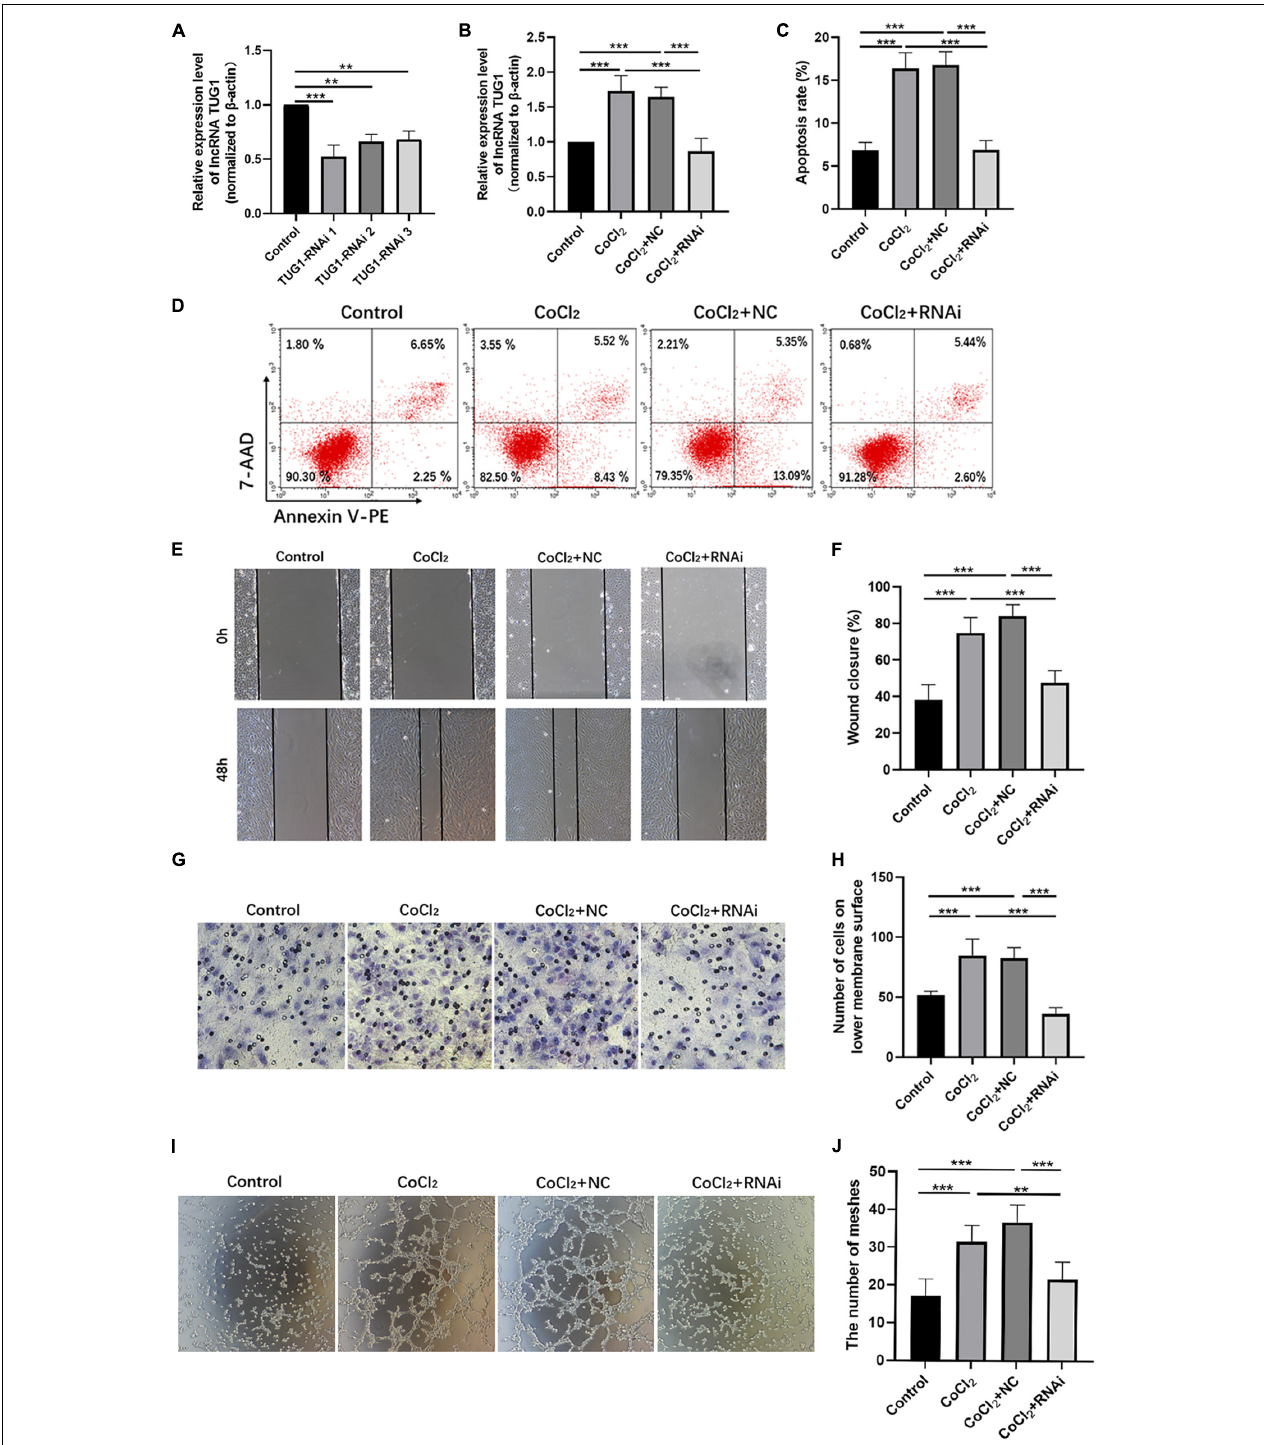
FIGURE 2 | Knocking down Tug1 inhibits apoptosis, migration, and angiogenesis in HRECs induced by hypoxia. (A) The transfection efficiency of TUG1-RNAi (mean ± SD, n = 3). *** P < 0.001, ** P < 0.01. (B) TUG1 expression level (mean ± SD, n = 5). *** P < 0.001. (C) Flow cytometry results showing the percentage of apoptotic cells (mean ± SD, n = 5). *** P < 0.001. (D) Results of flow cytometry with cells labeled with Annexin-PE and 7-Aminoactinomycin D (7-AAD). (E) Results of wound healing assay, 100 × magnification. (F) Quantitation of results from the wound healing assay in (E) (mean ± SD, n = 5). *** P < 0.001. (G) Results of transwell migration assay, 200 × magnification. (H) Quantitation of results from the transwell migration assay in (G) (mean ± SD, n = 5). *** P < 0.001. (I) Results of tube formation assay, 100 × magnification. (J) Comparison of the number of meshes in different treatment groups (mean ± SD, n = 5), *** P < 0.001, * P < 0.05.